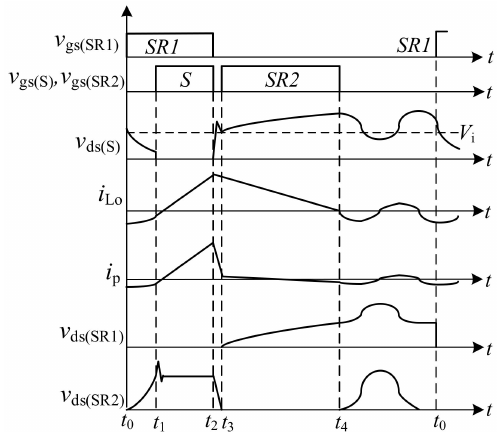
Figure 2. Key voltage and current waveforms of the proposed